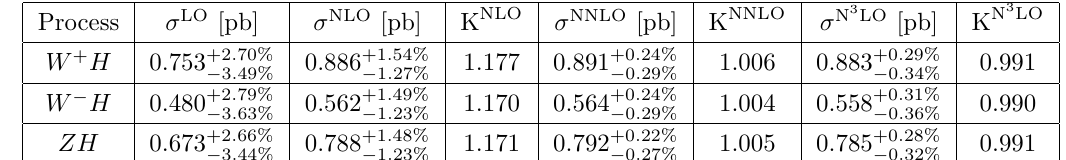
Table 1 . Total cross section for associated Higgs production up to the third-order in perturbation theory at a 13 TeV proton-proton collider for a fixed central scale choice µ set PDF4LHC15_nnlo_mc has been used for all predictions, and the K-factors, defined as K N k LO = σ N k LO /σ N k − 1 LO for k = 1 , 2 , 3 , are also given. The quoted uncertainties (in percent) are calculated using a 7-point scale variation around the central